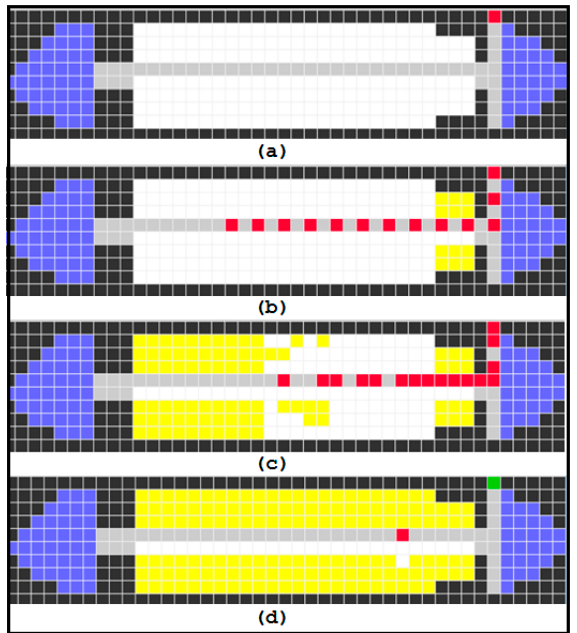
Figure 22. Back-to-Front strategy.